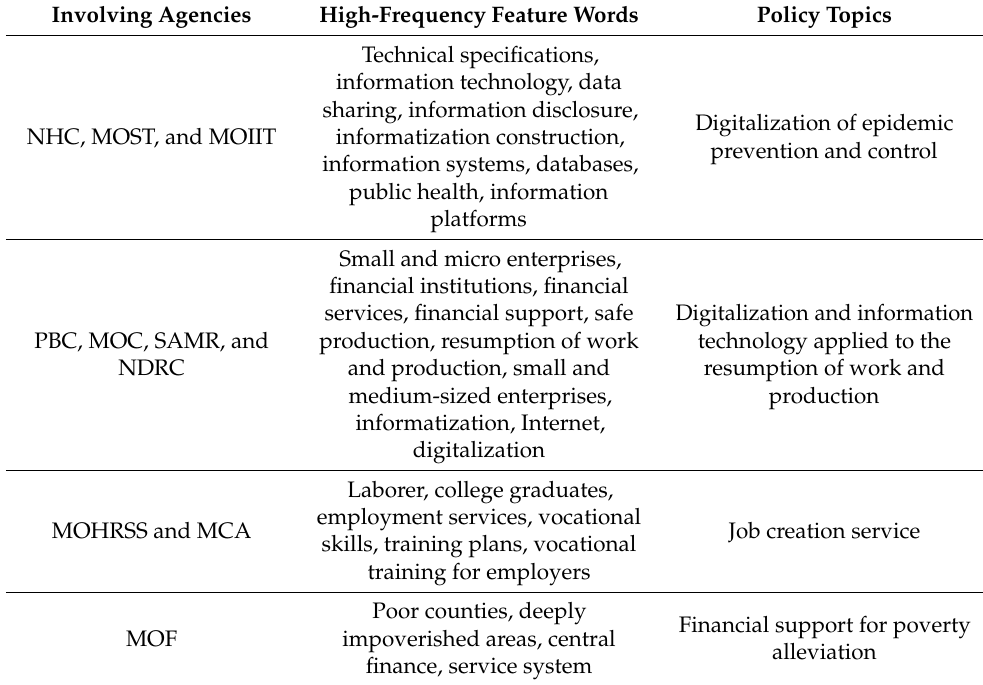
Figure 7. Agency–topic relationship network in the fourth phase. Table 6. Policy topics of interagency collaborative decision-making in the fourth